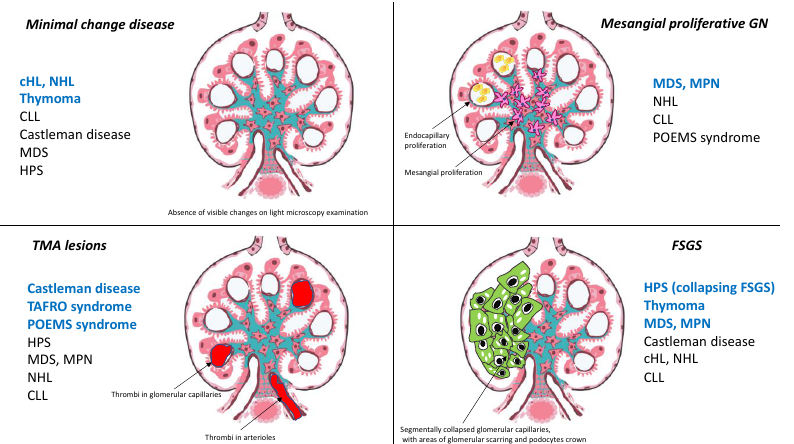
Figure 1. Main glomerular disorders (MCD, TMA, mesangial proliferative GN and FSGS) occurring in association with hematological malignancies and thymoma. The most relevant associations are highlighted in blue in the Figure. cHL: Classical Hodgkin lymphoma; CLL: Chronic lymphocytic leukemia; FSGS: Focal and segmental glomerulosclerosis; HPS: Hemophagocytic syndrome; MDS: Myelodysplastic syndrome; MPN: Myeloproliferative neoplasms; NHL: Non-Hodgkin lymphoma; POEMS: Polyneuropathy, Organomegaly, Endocrinopathy, Monoclonal protein, Skin changes syndrome; TAFRO: Thrombopenia, Anasarca, Fever, Reticulin myelofibrosis, and Organomegaly syndrome. 3. Hodgkin Lymphoma and Glomerular Disease: The Singular Case of Minimal Change Disease Classical Hodgkin lymphoma (cHL) is a hematologic disorder characterized by the uncontrolled proliferation of malignant cells known as “Hodgkin and Reed – Sternberg (HRS)” cells. These cells, which are derived from germinal center or post -germinal center B cells, have lost their B-cell phenotype and instead present a highly unusual pattern of expression of many markers from other hematopoietic cell lineages [30]. Many types of glomerulonephritis are recognized as associated with cHL, but the incidence of nephrotic syndrome is low and estimated at about 0.5 to 1% [3]. In two previous studies of 1700 patients with Hodgkin disease, two glomerulopathies were significantly associated with cHL: amyloidosis (0.1% of cases) and MCD (0.4% of cases) [31,32]. The association be- tween cHL and MCD is probably one of the best known among hematologic disorder- related paraneoplastic glomerulopathies [33]. AA amyloidosis has decreased in frequency with current therapeutic strategies, but other glomerular lesions, including FSGS, MN, MPGN and anti-glomerular basement membrane (anti-GBM) or pauci-immune crescentic glomerulonephritis lesions, may also be observed in patients with cHL [2,33,34]. Audard et al. reported the main clinical, biological, pathological and therapeutic characteristics of 21 patients (14 men, mean age of 28.5 years at the time of renal biopsy) with MCD occur- ring in a context of cHL [34]. Before this study, in the largest reported meta-analysis to date, Eagen et al. reported the simultaneous occurrence of cHL and MCD in 12 of 26 pa- tients [33]. By contrast, Audard et al. reported a median time of 15 months between the diagnosis of MCD and that of cHL (range: 0 – 156 months) [34]. Nevertheless, in patients suffering from cHL and MCD, the two diseases often appear to follow a remarkably sim- ilar course. Indeed, MCD remission occurs after the successful treatment of cHL, regard- less of the therapeutic strategy used, suggesting that this glomerular disease is a